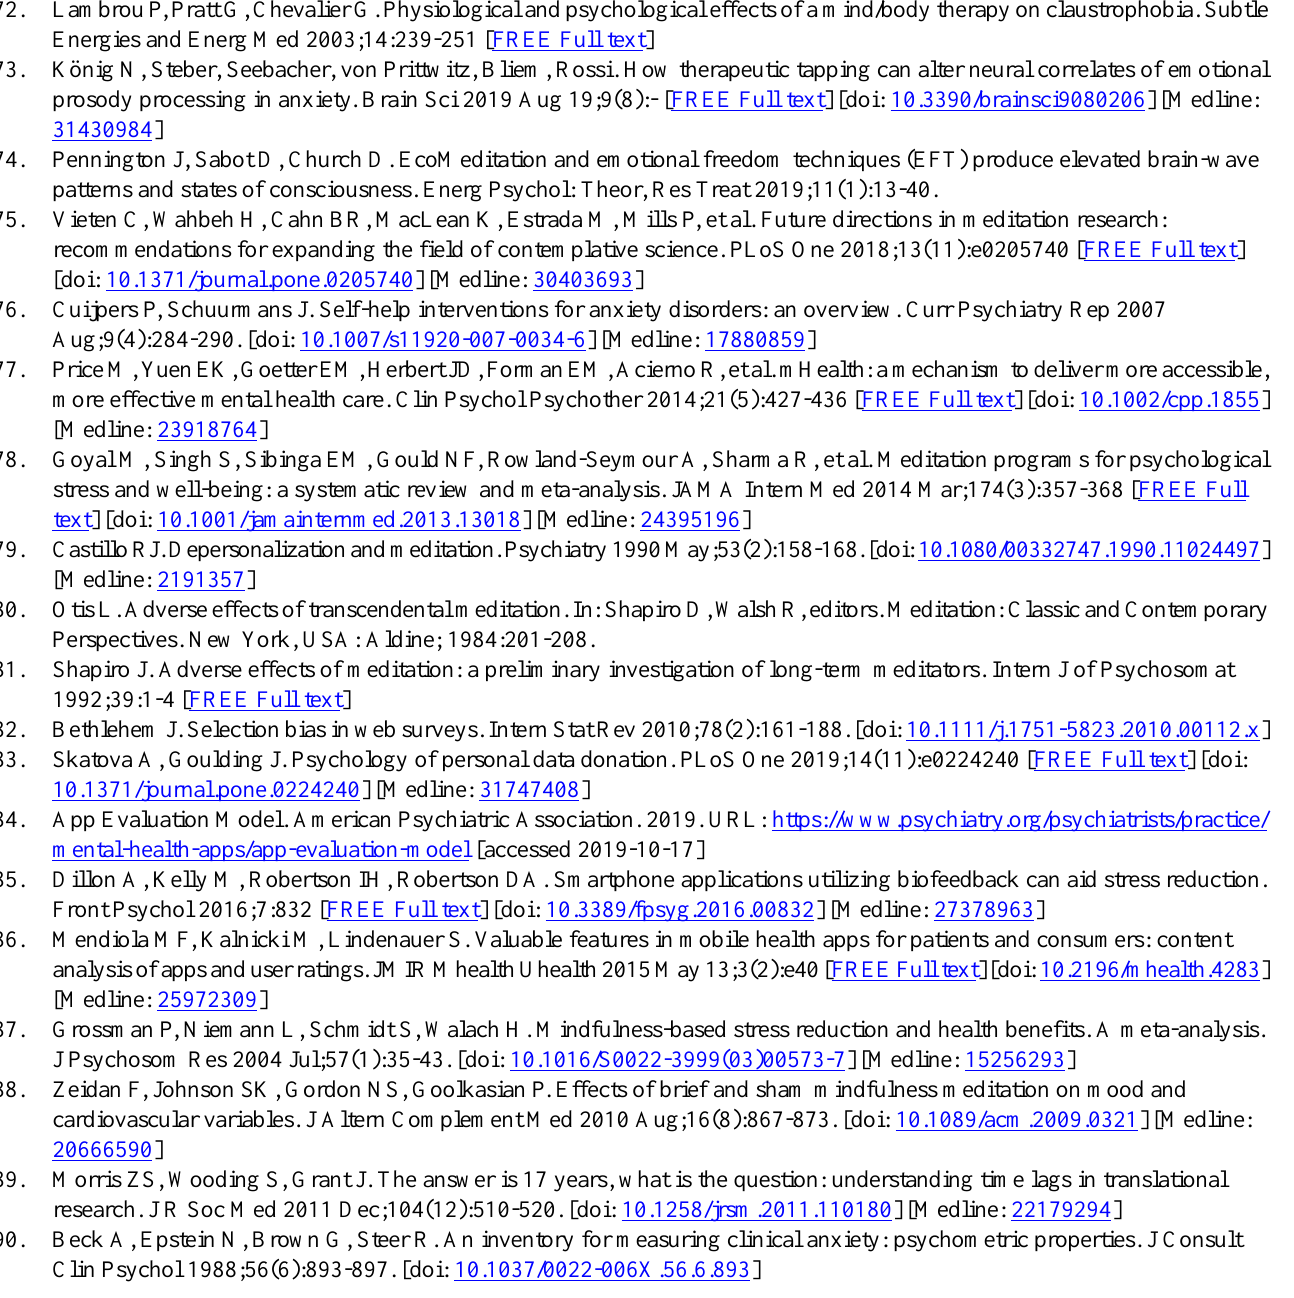
Abbreviations EFT: Emotional Freedom Techniques mHealth: mobile health PTSD: posttraumatic stress disorder RCT: randomized controlled trial SUD: Subjective Units of